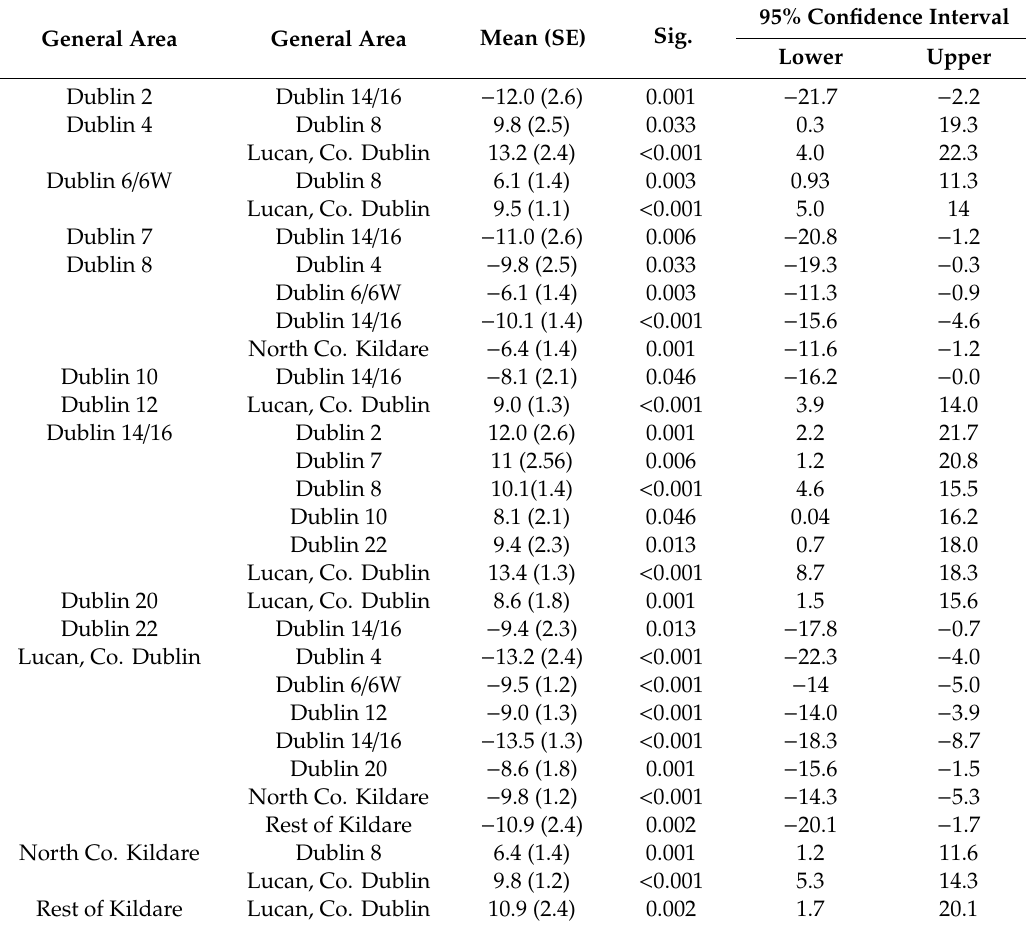
Table A2. Pairwise ANOVA